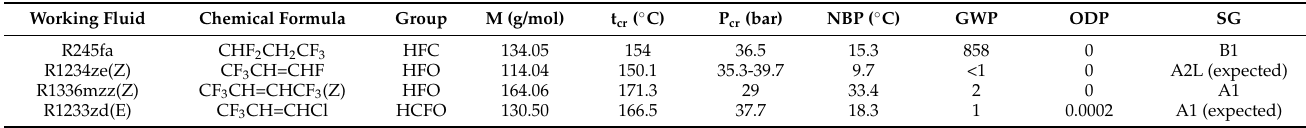
Table 1. Parameters of refrigerants in the HTC.